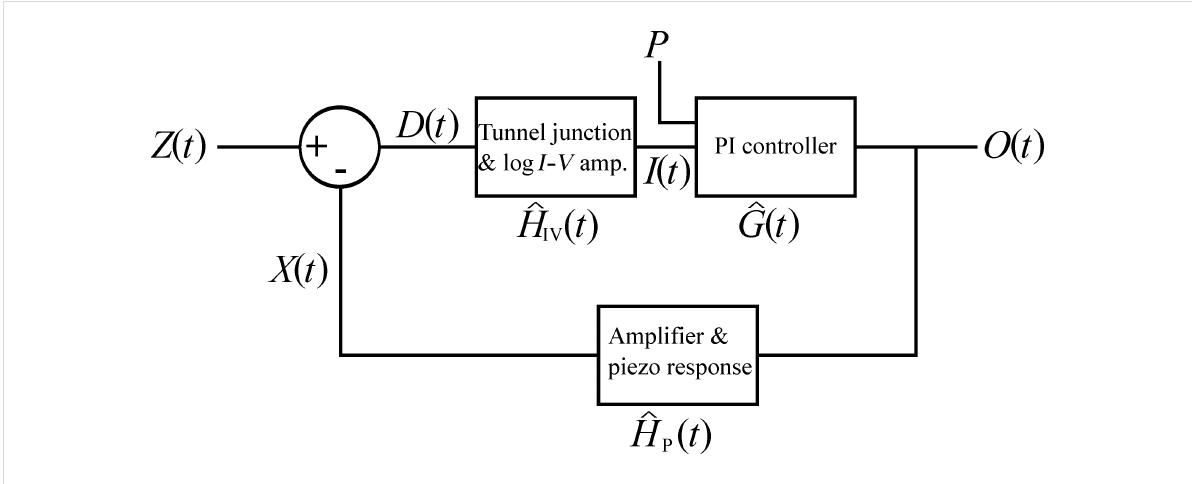
where is the time dependent operator fully describing the tunnel junction, the I – V amplifier, and the logarithm opera-